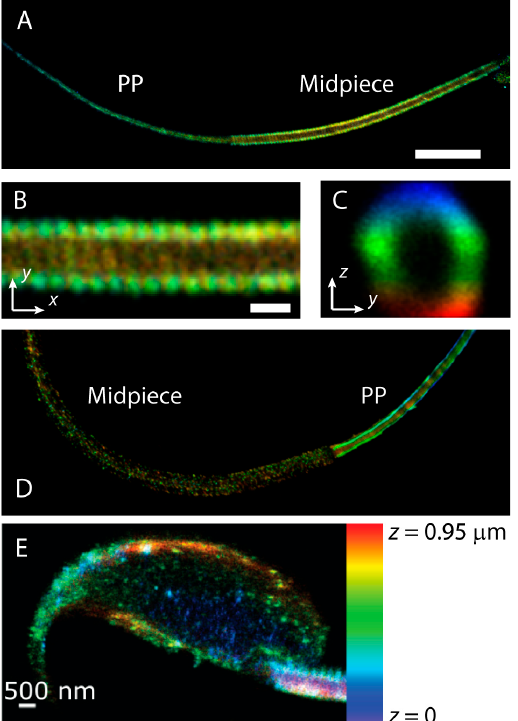
Figure 6. Examples of stochastically optical reconstruction microscopy (STORM) super-resolution imaging in mouse sperm cells. ( A ) Representative color-coded 3D STORM reconstruction of the actin cytoskeleton in the flagellum of mouse sperm. Actin was labeled with phalloidin-AlexaFluor 647. The midpiece and the principal piece (PP) are indicated for clarity. Scale bar: 5 μ m. Imaged by Xinran Xu and Maria G. Gervasi [223]. The actin structure in the midpiece is found to be arranged in a double helix. ( B ) Zoom of the midpiece structure. Scale bar: 500 nm. ( C ) Cross section of the midpiece structure. ( D ) Representative 3D STORM reconstruction of actin-associated protein adducin in the mouse sperm flagellum. ( E ) Representative 3D STORM reconstruction of the actin cytoskeleton in the head of non-capacitated mouse sperm. Imaged by Xinran Xu and Mariano Buffone [228]. The color bar on the right shows the axial localization of this reconstruction.